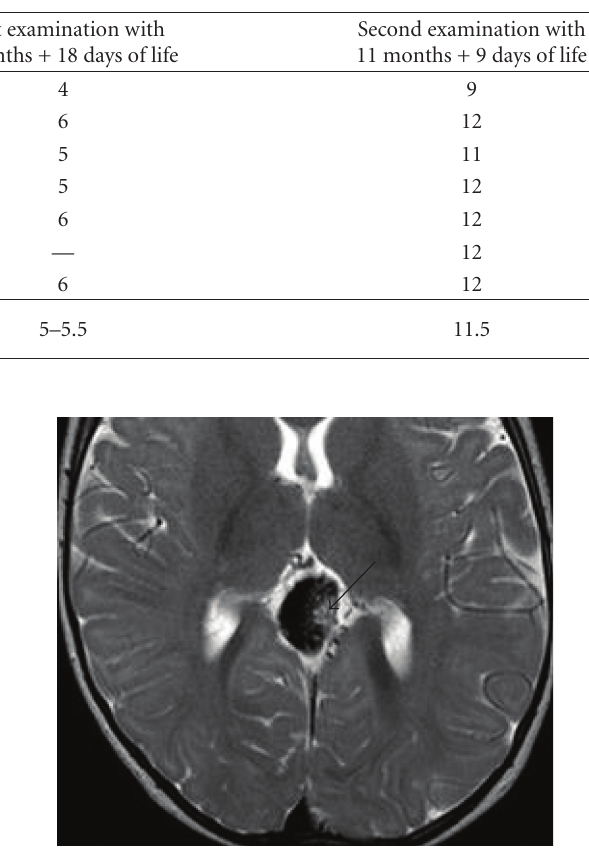
Table 2: State of development of the patient after a standardized developmental test for the first year of life (so called “M¨unchener Funk- tioneller Entwicklungstest” (MFED1) ). Examination at the time of 5th and 11th month of life. Data of tested criteria for the stage of develop- ment in corresponding age in month.